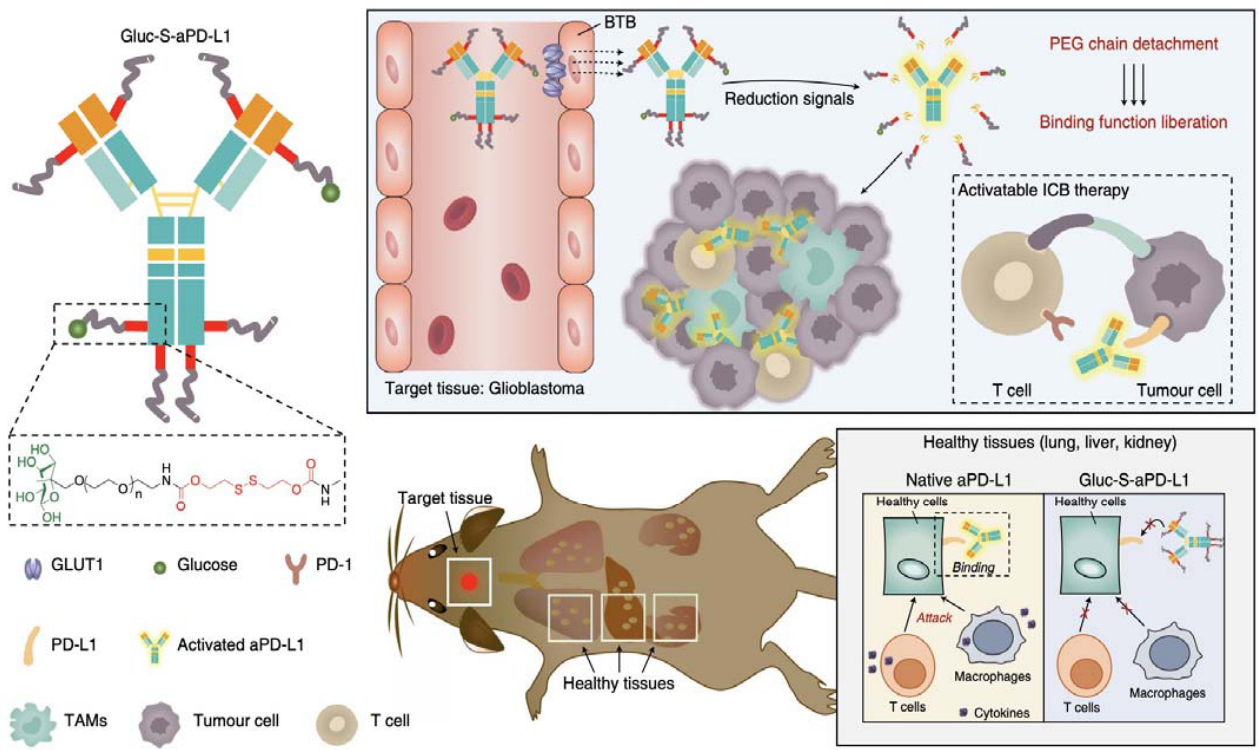
Figure 4. Glycosylated ‐ PEGylation of anti ‐ PD ‐ L1 antibodies for creating a targeted immunotherapy against glioblastoma. The glycosylated ‐ PEGylation allowed the active transport of the antibody through the BBTB of glioblastoma by targeting the GLUT1 on the endothelial cells. Inside the tumor, the antibodies were dePEGylated by the cleavage of the reduction ‐ sensitive bonds. In off ‐ target tissues, the coated antibodies remained silent, avoiding the immune ‐ related adverse events. Reprinted with permission from reference [76]. Copyright Nature 2021.